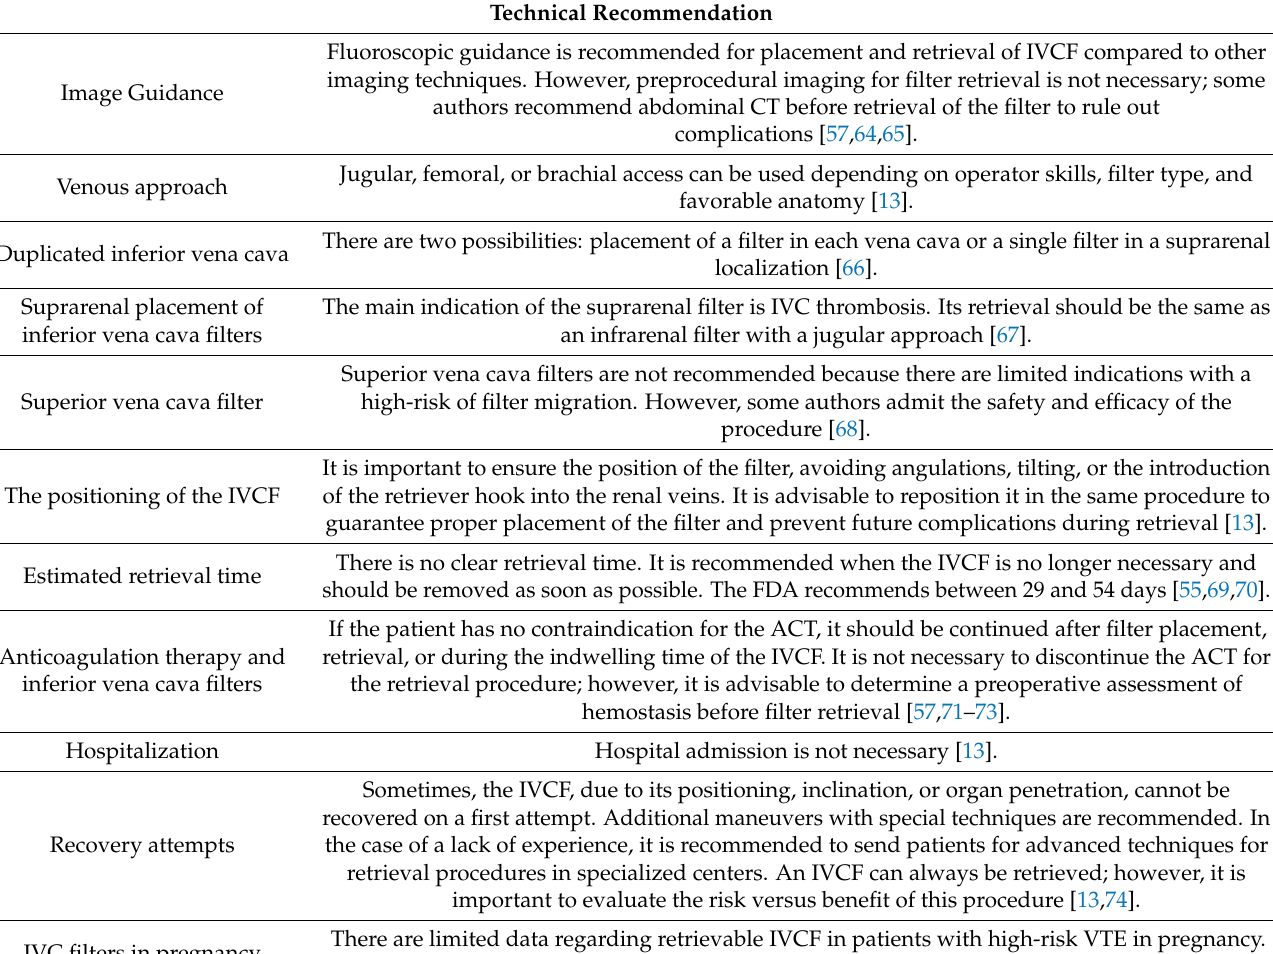
Table 3. SIDI and SERVEI recommendations (modified SIR)